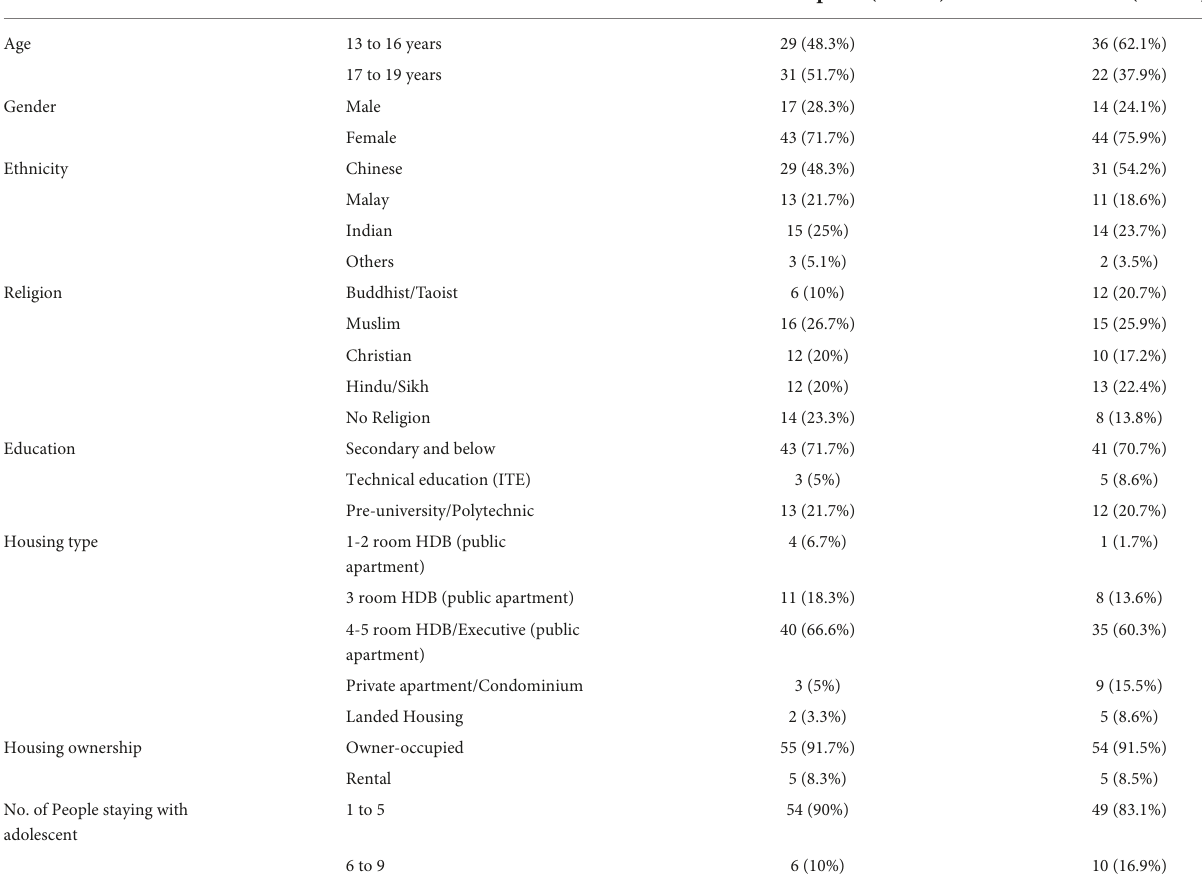
TABLE 1 Demographic characteristics of